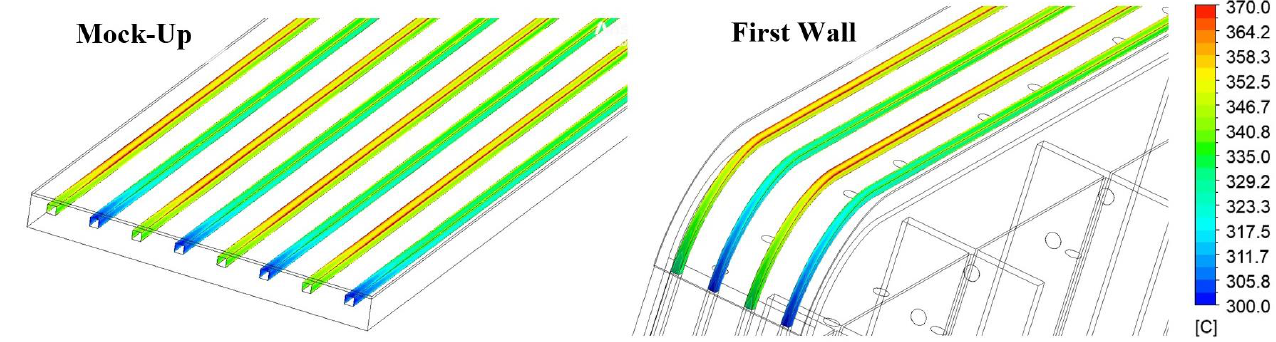
Figure 5. Wall-to-liquid HF ( a ) and wall temperature ( b ) along the front-side-wall center of a refer- ence channel.